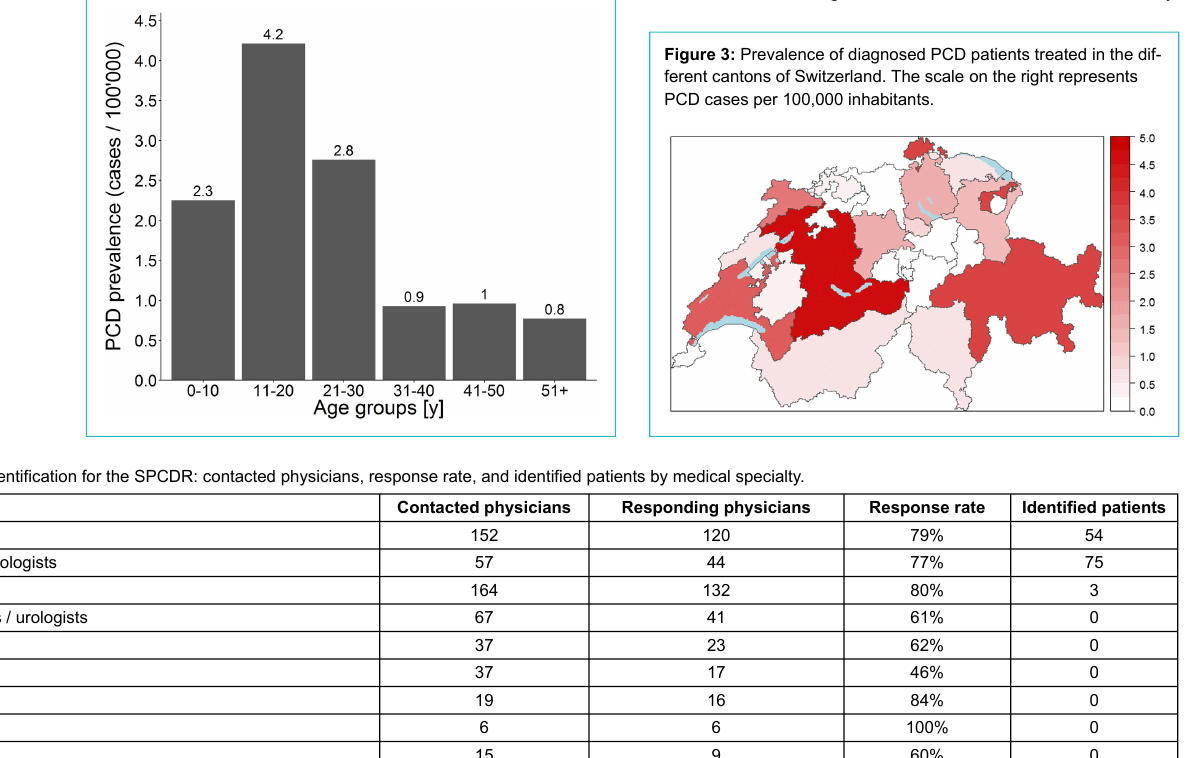
Figure 3: Prevalence of diagnosed PCD patients treated in the dif- ferent cantons of Switzerland. The scale on the right represents PCD cases per 100,000